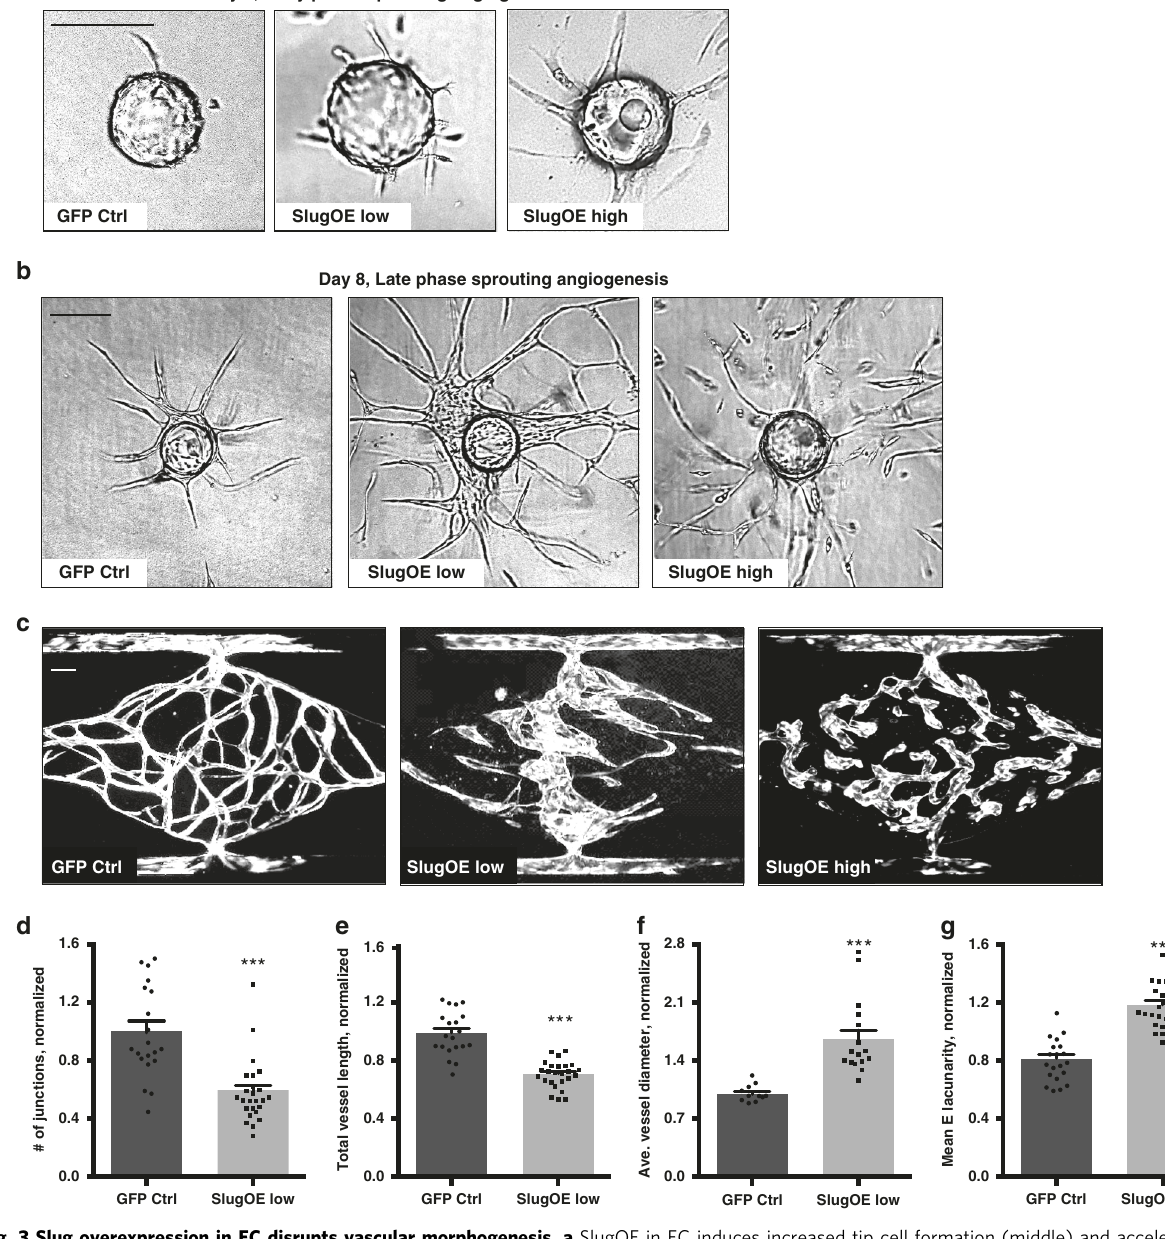
SlugOE low cells formed distorted vessels with larger diameters and fewer branch points (Fig. 3c – g), while SlugOE high cells were mostly incapable of forming networks (Fig. 3c). In addition, EdU staining revealed increased proliferation in SlugOE low EC (Supplementary Fig. 7d), consistent with our results in the retinal angiogenesis model (Fig. 2h), and previous reports 36 . In aggregate, these data demonstrate that Slug regulates blood vessel formation in a dose-dependent manner.